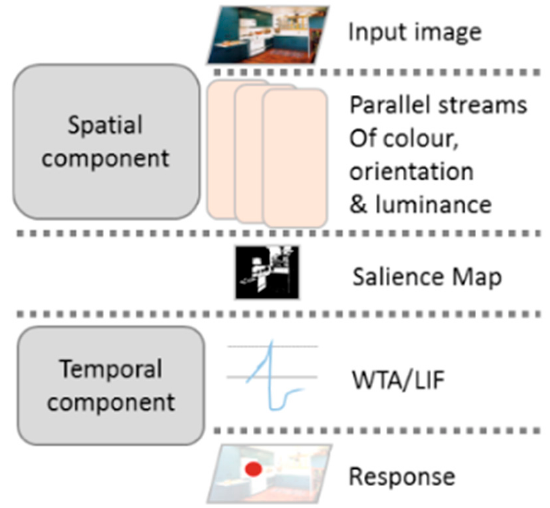
The neuron fires if the membrane potential V is higher than the threshold potential